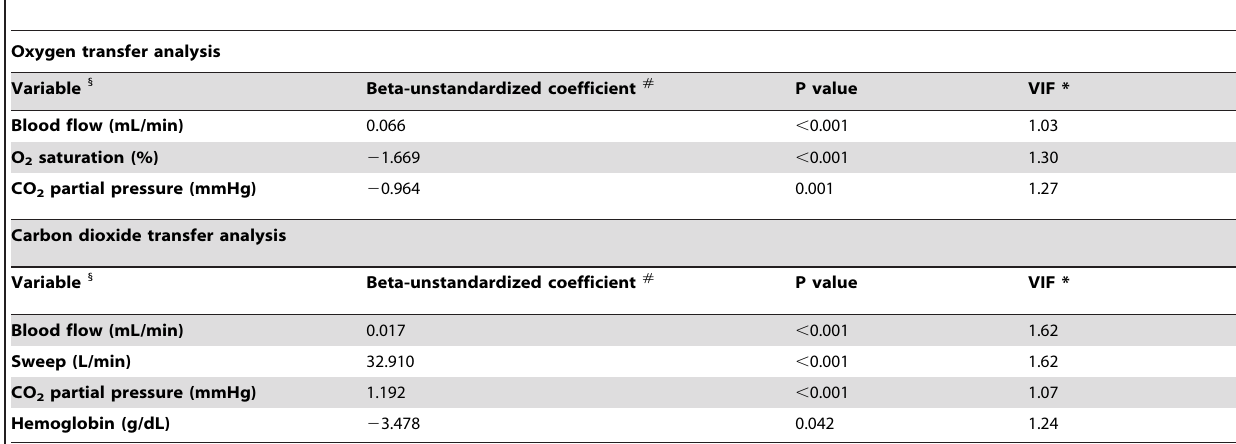
Table 2. Backward elimination multivariate analysis exploring variables associated with oxygen and carbon dioxide transfer during ECMO support.